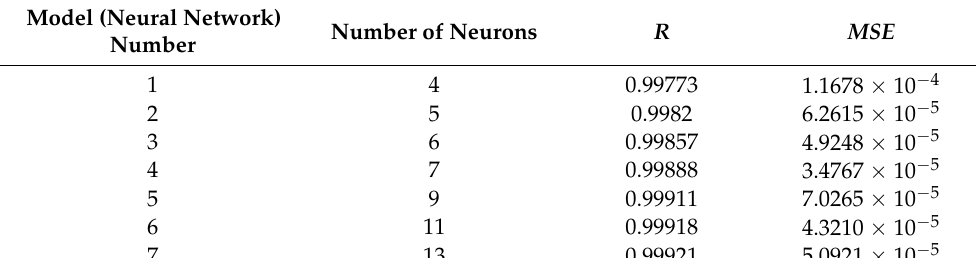
Table 5. Neural network parameters and the learning outcomes. Model (Neural Network)